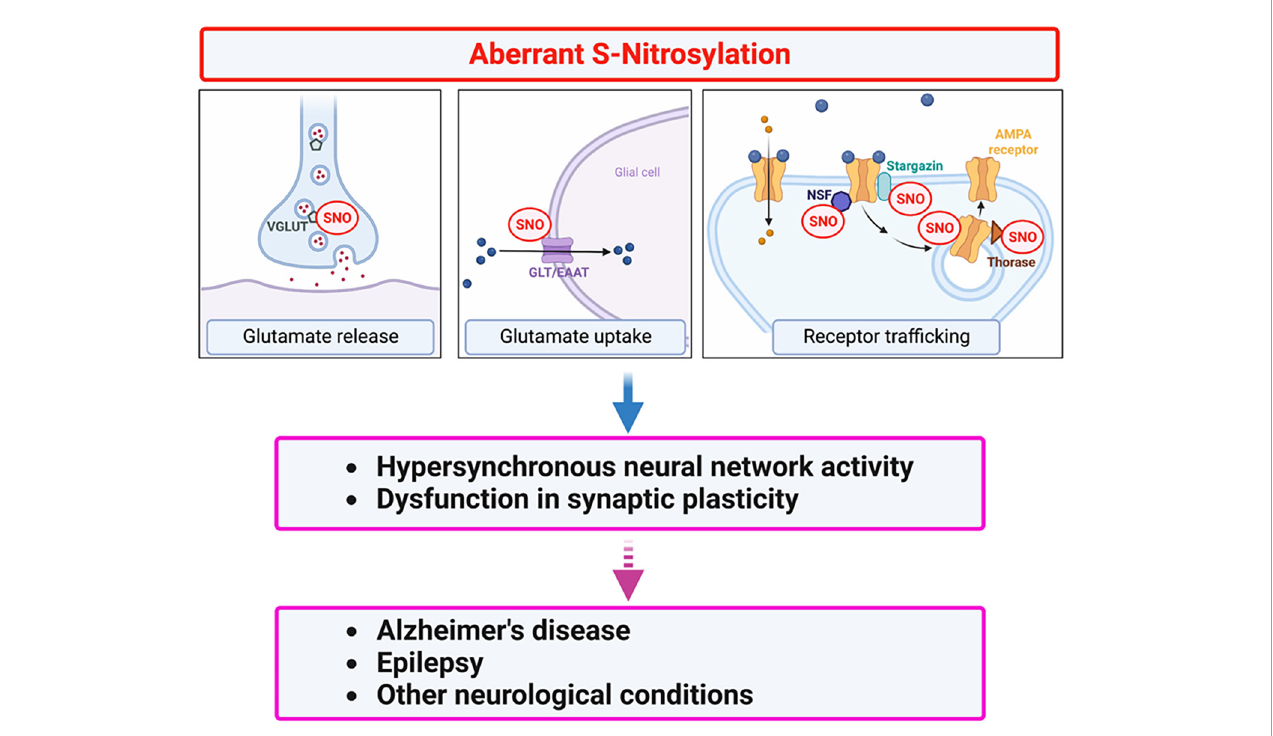
FIGURE3 Protein S-nitrosylation regulates glutamatergic signaling contributing to hyperexcitability in AD. Excessive production of NO-related species due to hyperactivation of NMDA-type glutamate receptors results in S-nitrosylation (SNO) of multiple proteins. These include several proteins involved in glutamate release and re-uptake as well as AMPA receptor trafficking. For example, in addition to regulating NMDA receptor activity (see Figure 2 ), NO-mediated S-nitrosylation can regulate glutamatergic signaling via (i) vesicular glutamate transporter 1 (VGLUT1) involved in glutamate release, (ii) glutamate transporter-1 (GLT-1)/excitatory amino-acid transporter 2 (EAAT2) involved in glutamate clearance, and (iii) AMPA receptor subunits (e.g., GluA1) as well as AMPA receptor-associated proteins, such as stargazin, N-ethylmaleimide sensitive factor (NSF), and Thorase, involved in AMPA receptor recycling. Dysfunction in glutamate signaling can contribute to hyperexcitability and impaired synaptic plasticity in AD and other neurological